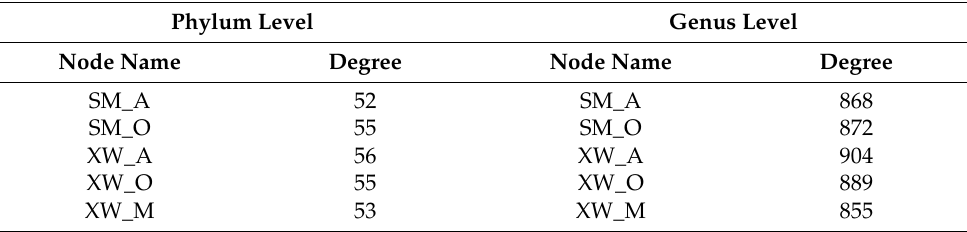
Table 4. The samples nodes at the phylum level and genus levels of the microbial communities associated with the wastewater treatment